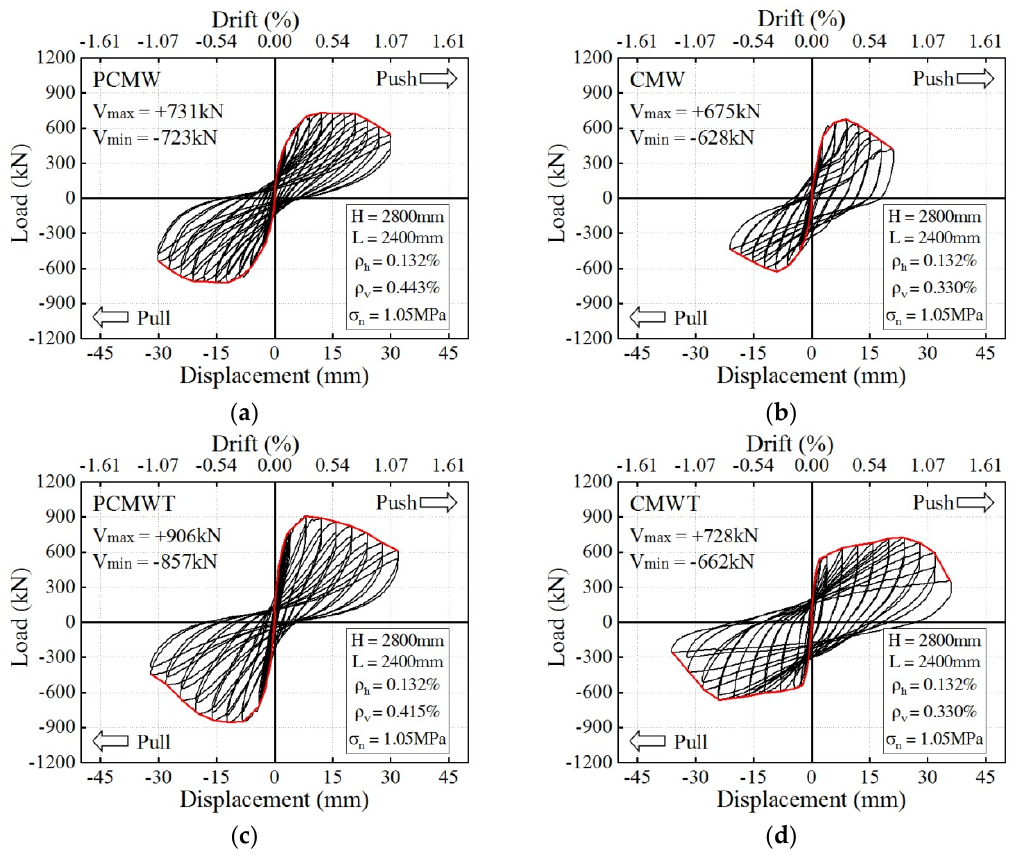
Figure 7. Hysteresis curves of the specimens: ( a ) PCMW, ( b ) CMW, ( c ) PCMWT, and ( d ) CMWT.